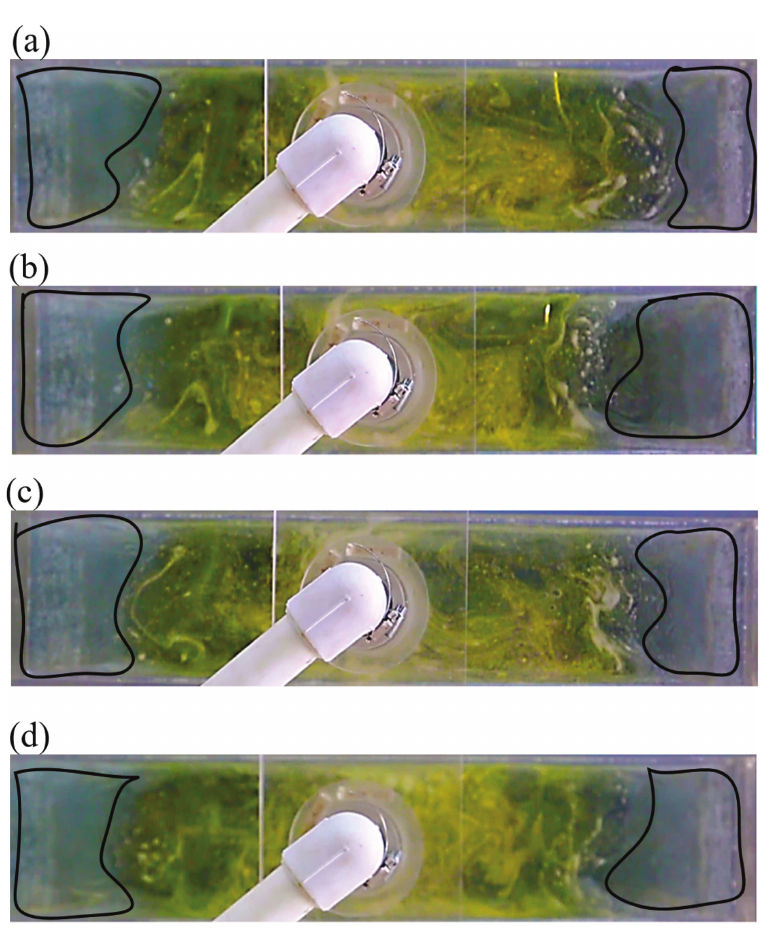
Figure 13: Experiment observation of the slag “ eye ” regions with casting speed of 1.7m/min at different